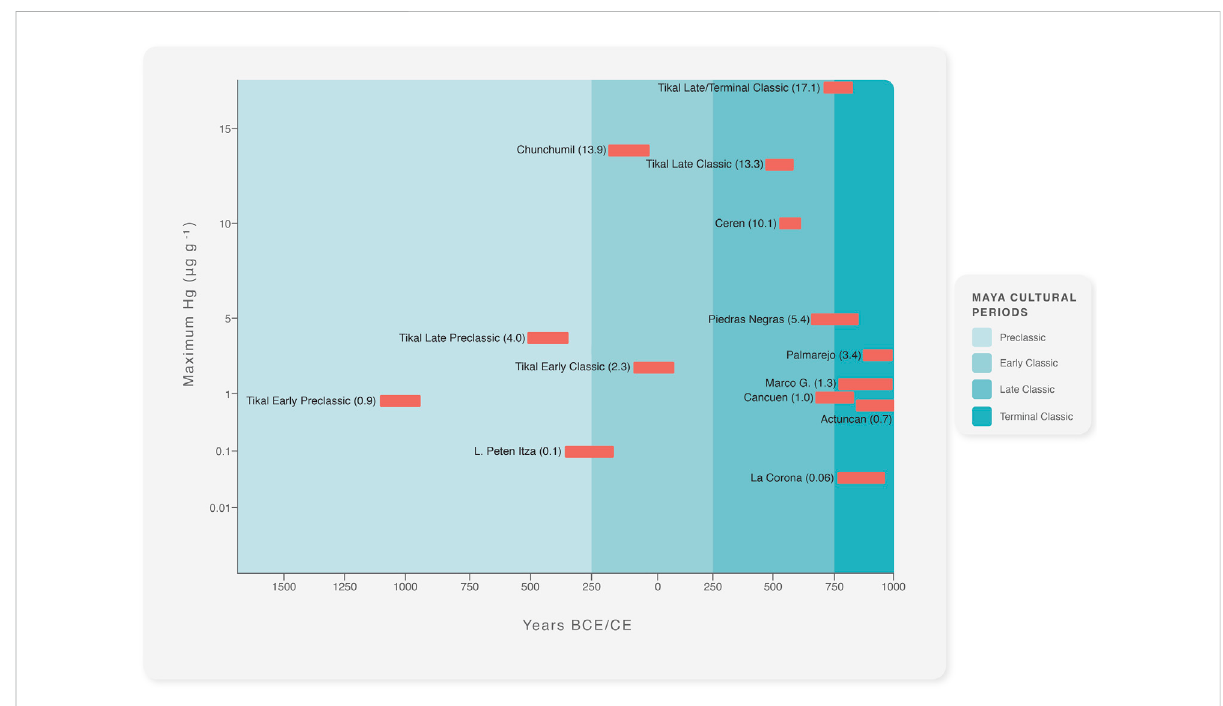
FIGURE 5 The chronology and magnitude of mercury pollution in soils and sediments at (or near) ten pre-Columbian Maya sites. Mercury data and chronological information collated from the sources cited in Section